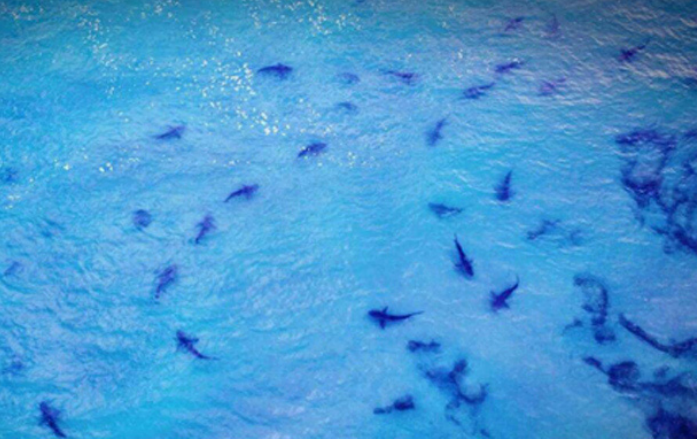
Figure 22. Shark aggregation near the discharge of warm cooling water of Orot Rabin Power Station in Hadera (drone photography by Kobi Sror).